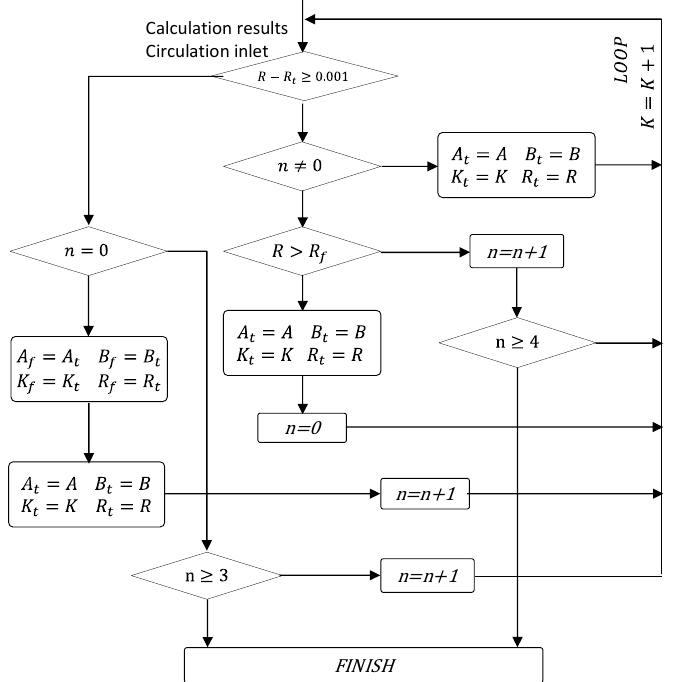
Figure 2. Loop iteration calculation method chart (Main loop idea: Set the circulation step of K value as 1.0, and calculate the A and B values according to the measured points. If the fitting coefficient R 2 of the model is greater than 0.99, it is regarded as the potential solution, and the potential solution appears three times in a row is the optimal solution, otherwise the output failures.).